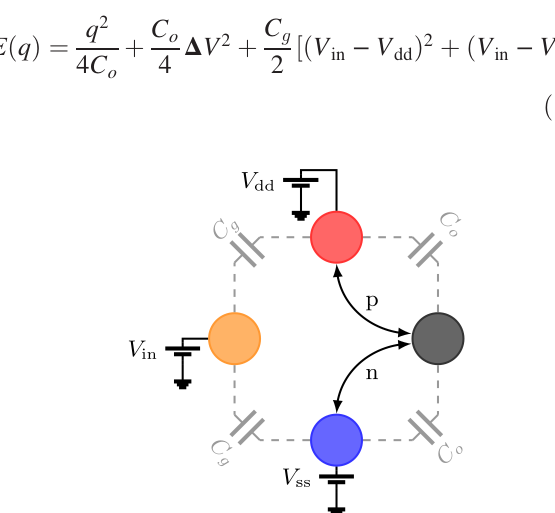
FIG. 10. Representation of the CMOS inverter as a set of three regulated and one free conductors and two conduction channels. The capacitors represent the mutual capacitances between